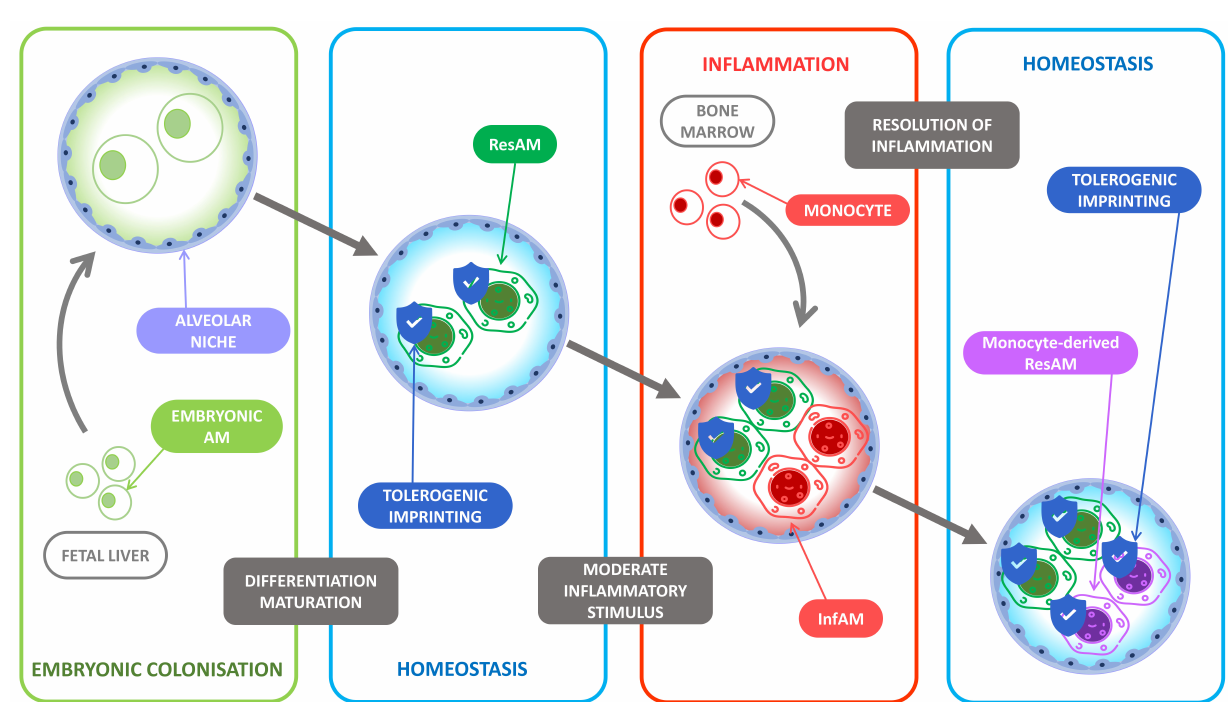
Figure 1. Tolerogenic imprinting throughout inflammation. At birth, the alveolar niche is colonized by fetal liver-derived monocytes. The lung microenvironment then favors their differentiation into resident alveolar macrophages (ResAM) and induces an unalterable tolerogenic imprinting. During inflammation, the main inflammatory actors are the recruited bone marrow-derived monocytes that differentiate into monocyte-derived alveolar macrophages (InfAM) under the pressure of the proinflammatory microenvironment while the ResAM display poor inflammatory functions as most of their tolerogenic imprinting remains. At the resolution of inflammation, the recruited InfAM become monocyte-derived ResAM and undergo the tolerogenic pressure of the microenvironment and display in turn a tolerogenic imprinting to limit further inflammatory response.